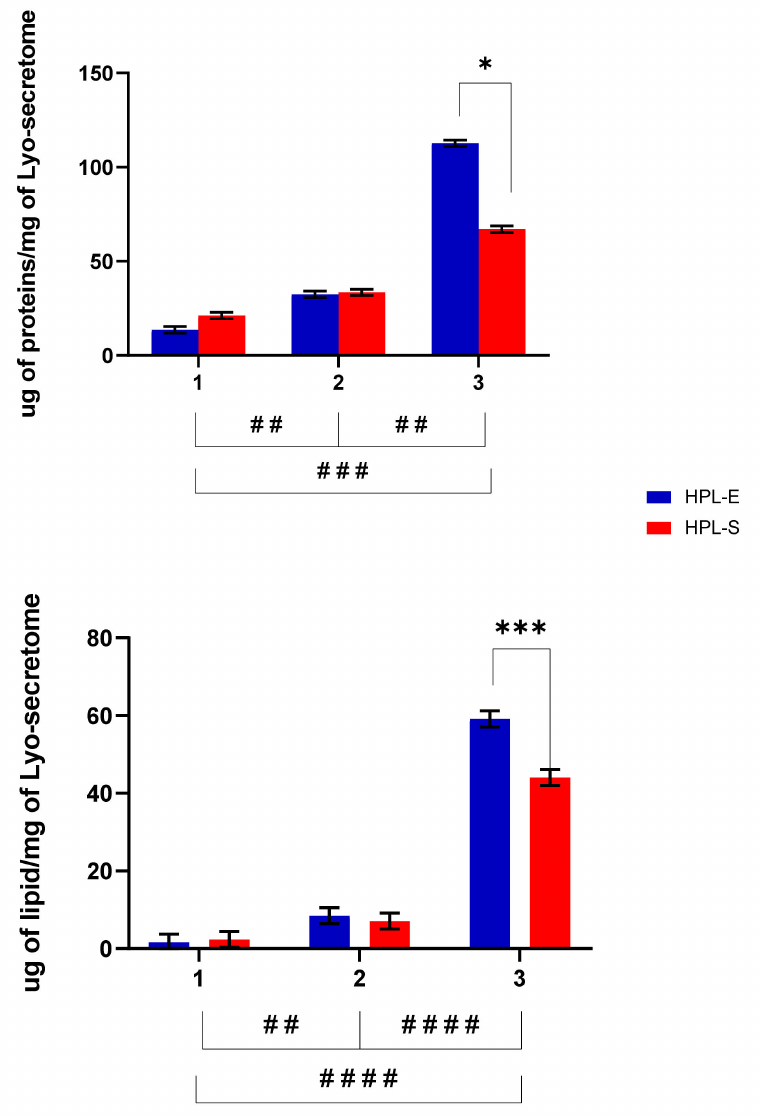
Figure 2. Protein and lipid content of freeze-dried secretome obtained from 3 different BM cell lines (1, 2, and 3) expanded with HPL-E or HPL-S. Multifactor ANOVA, mean values ± LSD, n = 3 are indicated. The symbols ##, ### and #### indicate a significant difference between the means of the different batches (respectively, p < 0.01, p < 0.005 and p < 0.0001), while the symbols * and *** indicate a significant difference between the two HPLs in the same batch (respectively, with p < 0.05 and p <